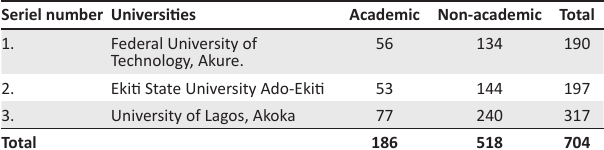
TABLE 1. Distribution of sample size amongst the